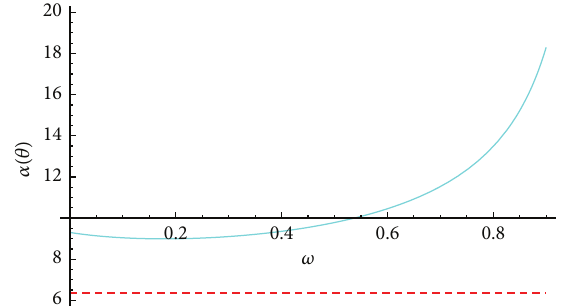
Figure 5: Deflection angle 𝛼 for the string cloud is evaluated at 𝑢 = 𝑢 + 0.03 as a function of 𝜔 . The Schwarzschild limit is shown by a horizontal dashed